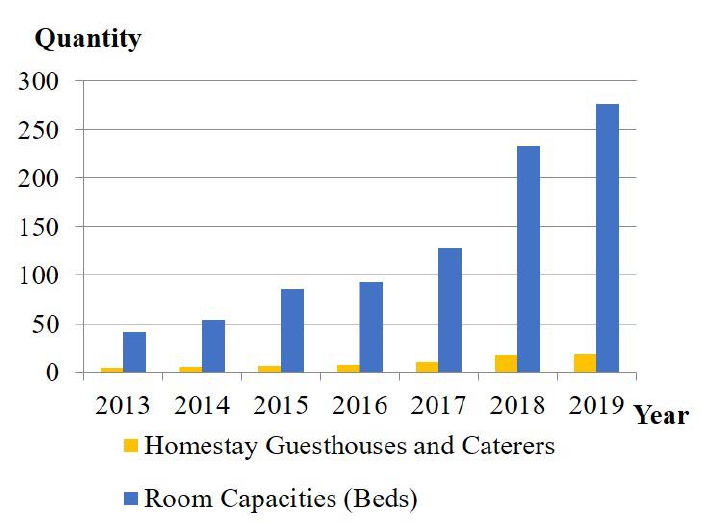
Figure 6. The change in homestay guesthouses and caterers in Baiyankeng village (2013–2019) (data provided by the village